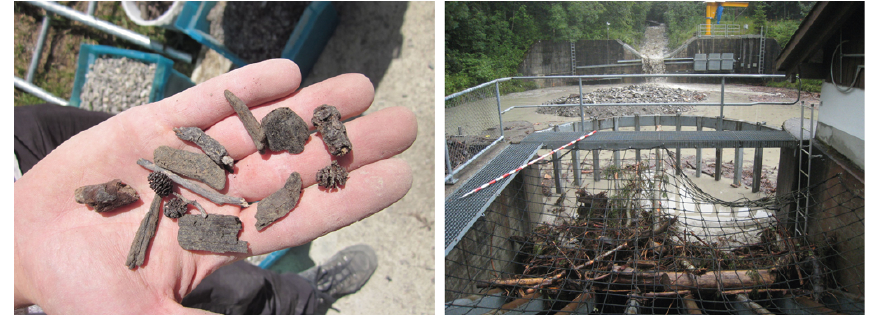
Figure 2. (left panel) Typical CPOM pieces caught in the basket samplers, including twigs, chips of woody material, bark fragments, scales of conifer cones, and alder catkins. The typical dry mass of the pieces shown ranges from a tenth of a gram up to a few grams. (right panel) LWD material caught in the outlet grid of the retention basin in the extreme event from 1 August 2010 (picture taken on the 2 August 2010). The retention basin and the basket samplers can be seen in the